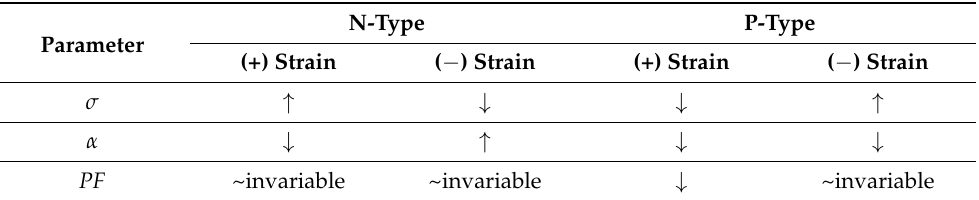
Table 5. Implications of the trends described by the electrical conductivity and Seebeck coefficient on the power